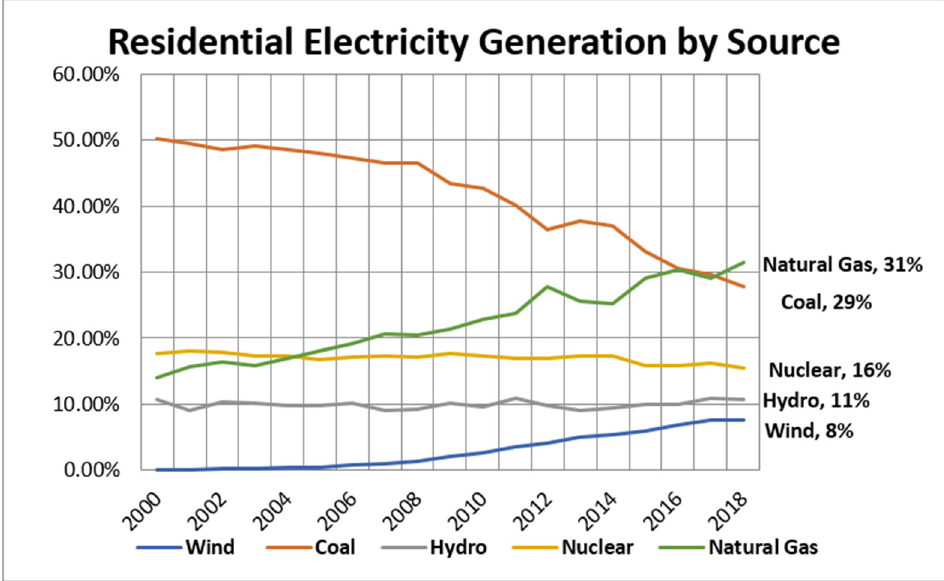
Figure 1. Electricity production by source. Source: US Energy Information Administration [12].